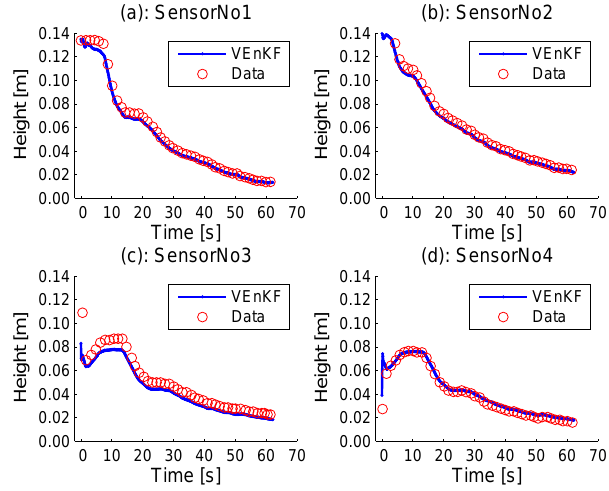
Fig. 11. Experiment 2: Comparison of VEnKF results and measured depth of the dam break experiment for the first four sensors at the upstream end.